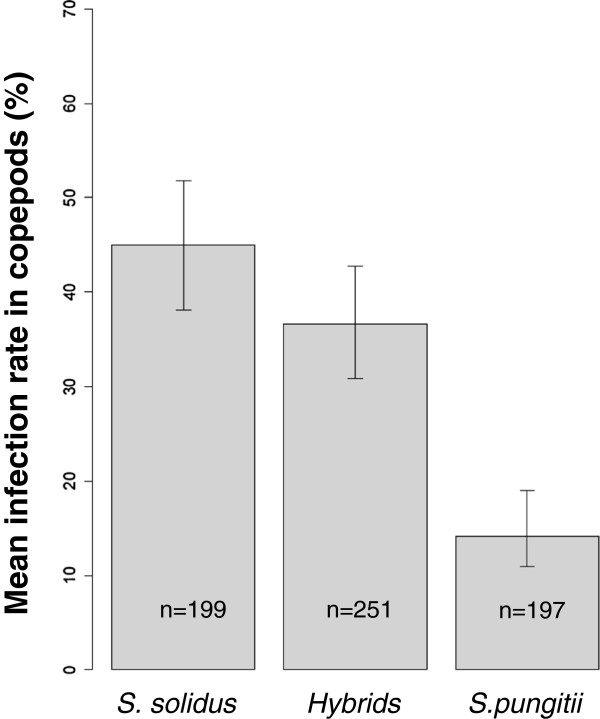
Mean infection rate in copepods. Error bars show 95% CI.